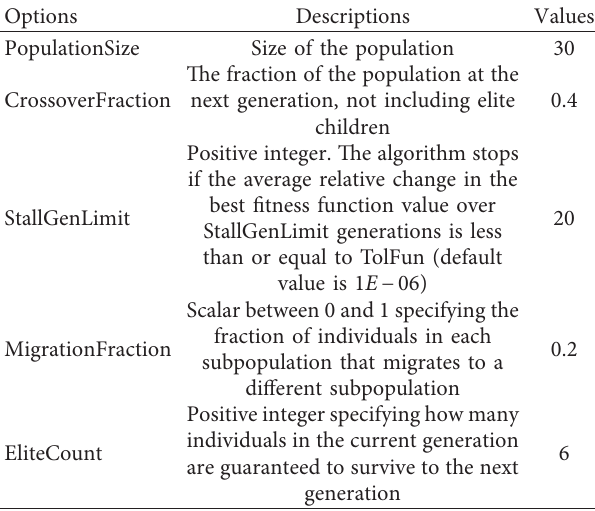
Figure 1: Genetic algorithm calculation process. Table 1: Main parameter values of